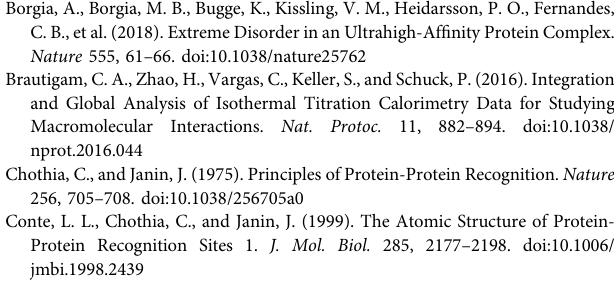
Figure S6 . Structures used for calculation are listed in Supplementary Table S1